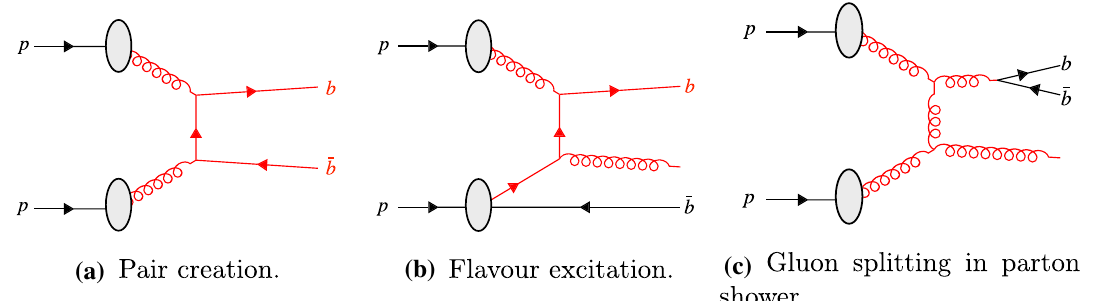
Fig. 1 Examples of production mechanisms for heavy quarks in proton–protoncollisions.Theincoming,outgoingandintermediatepar- ticles of the process considered to be the hardest process are highlighted